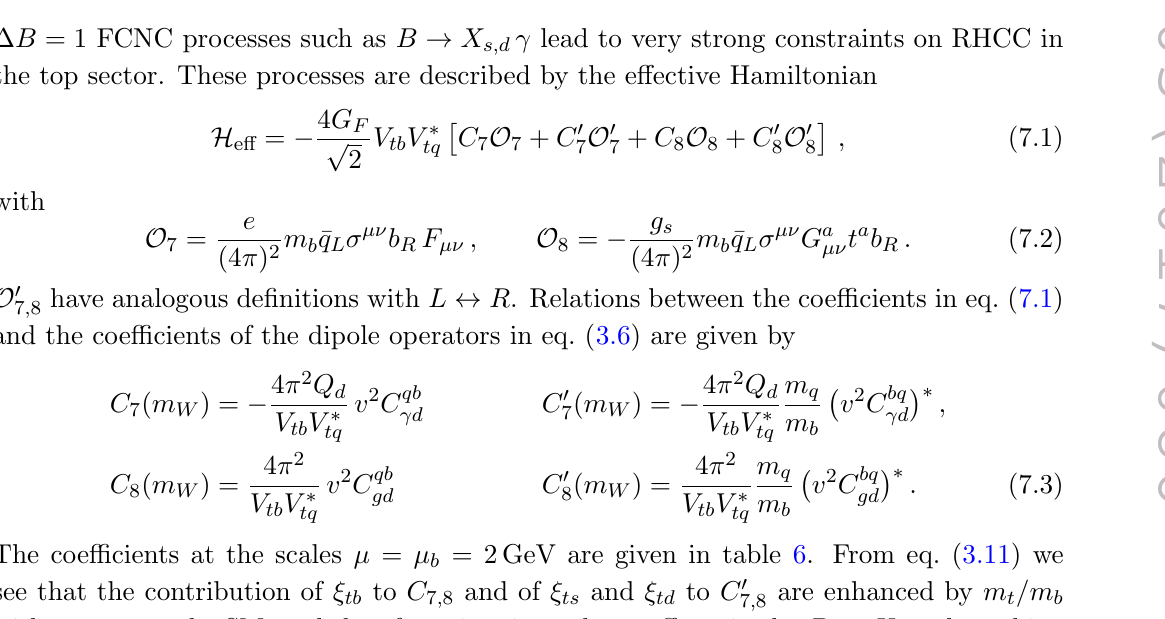
Table 11 . Experimental input for the processes discussed in section 7 [71, 101]. The branching ratios BR ( B ! X d;s (cid:13) ) have a cut on the photon energy, E (cid:13) > 1 : 6 GeV.